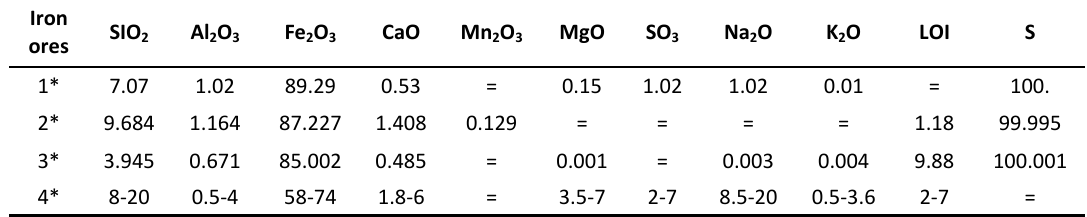
Table1. Chemical composition of iron ores, %